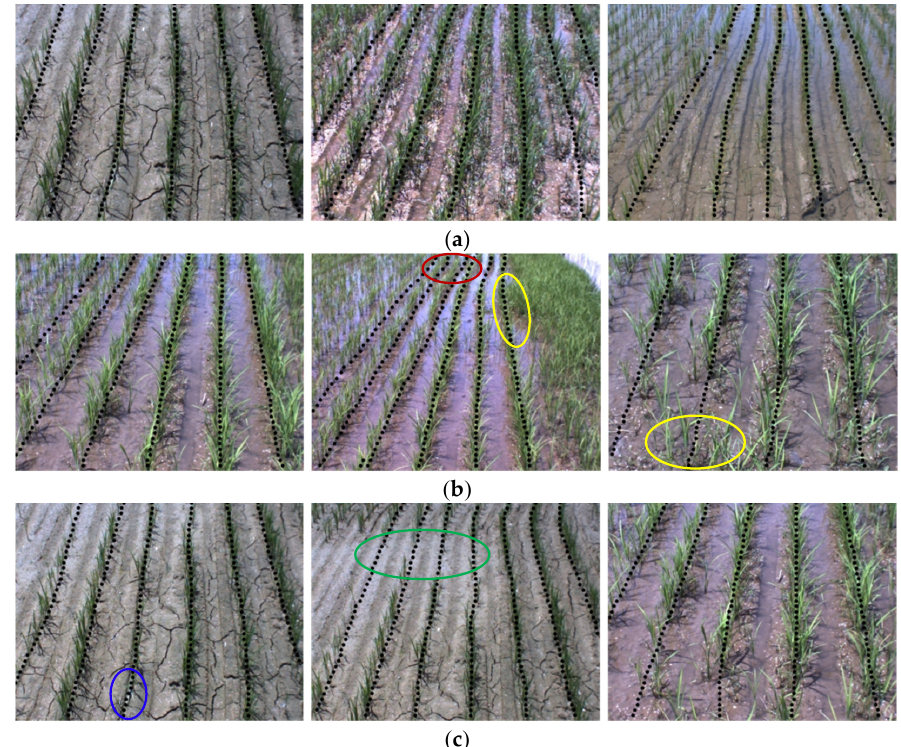
Figure 9. Results of feature layer visualization in different scenes: ( a ) Normal scenes; ( b ) Lack of seedling scene; ( c ) Weed scene; The red circle represents where the rice rows converge; The yellow circles represent the areas of weed cover in rice fields; The green circles represent the rice rows where there are extensive seedling deficiencies; The blue circle represents the curved rice row.